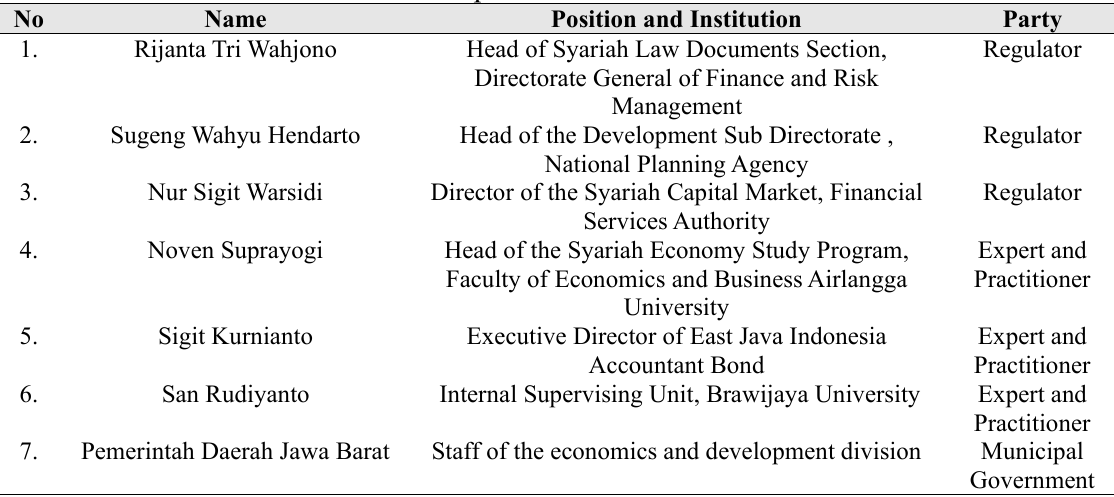
Table 1 Experts Involved in the